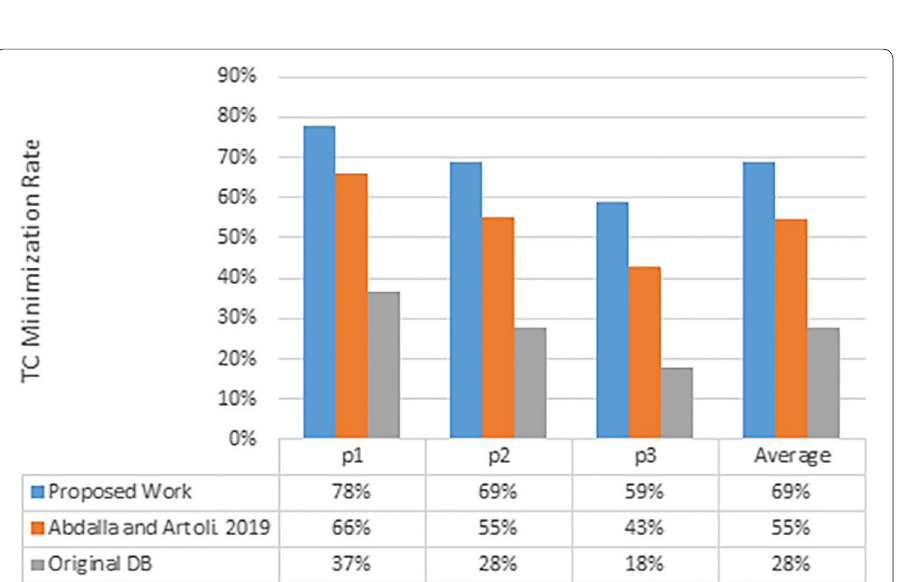
Fig. 12 Scenario 2—TC minimization in percentage: take the average TC over all